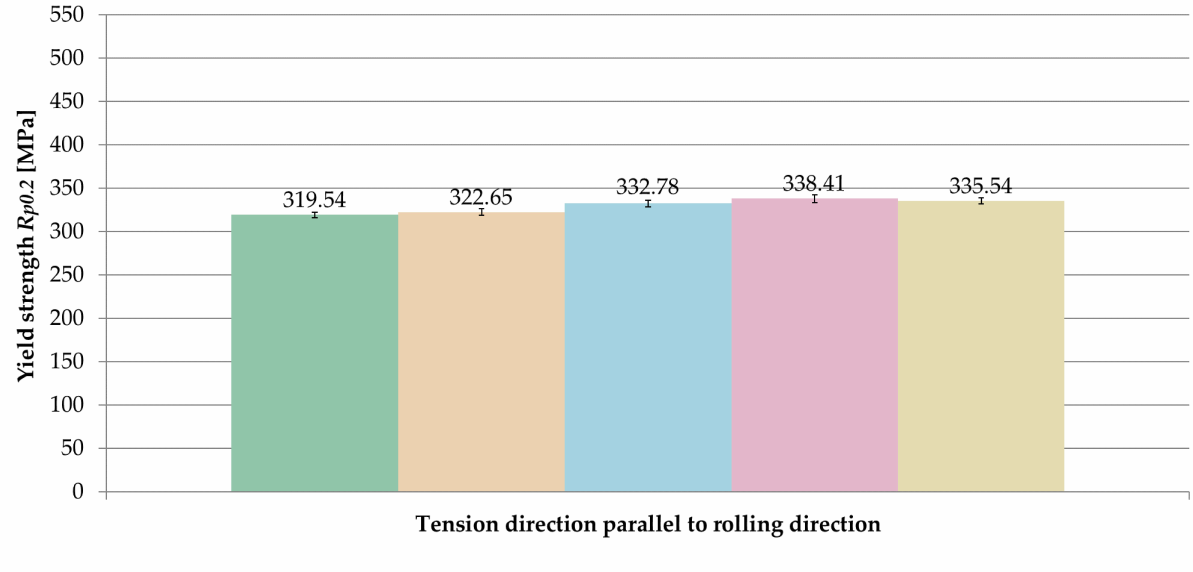
Figure 12. Comparison of yield strength R p 0.2 for samples stretched perpendicular to the rolling direction.